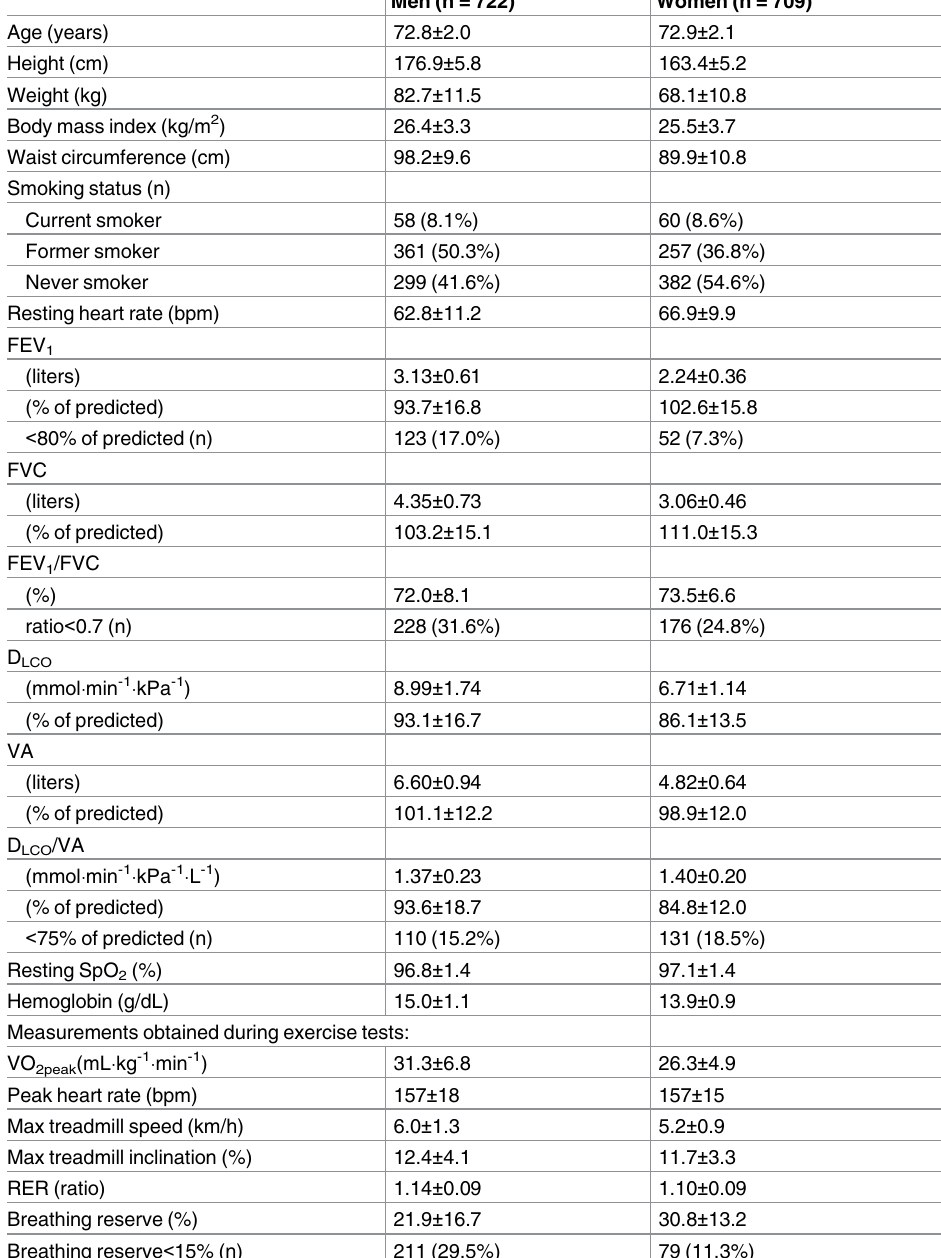
Table 1. Descriptive statistics for